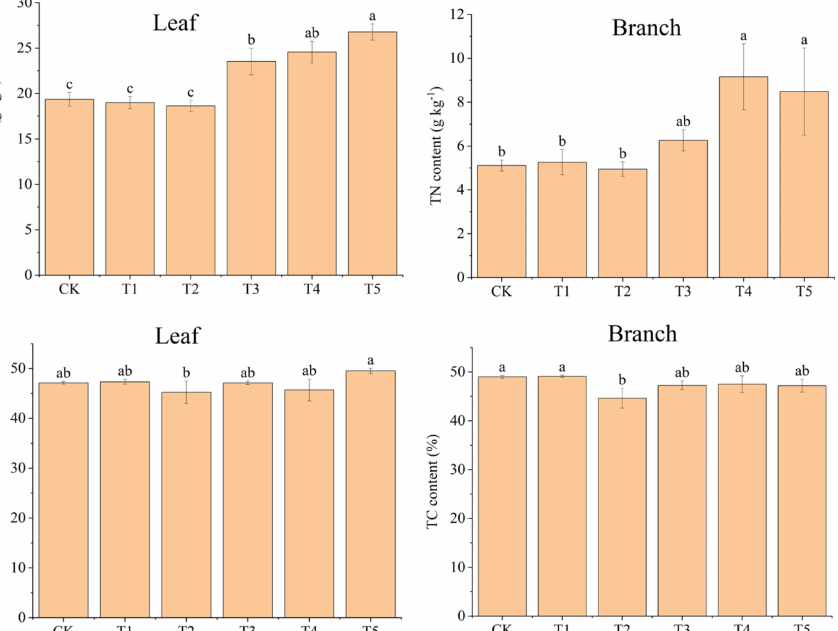
Figure 3. Effects of different treatments on total nitrogen (TN) and total carbon (TC) contents of moso bamboo (leaf and branch). CK: no biochar and no N addition; T1: 0.64% biochar + 0% NH 4 NO 3 ; T2: 1.28% biochar + 0% NH 4 NO 3 ; T3: 0% biochar + 1.28% NH 4 NO 3 ; T4: 0.64% biochar + 1.28% NH 4 NO 3 ; T5: 1.28% biochar + 1.28% NH 4 NO 3 . Bars (standard deviation) followed by different lowercase letters indicate significant difference at p <